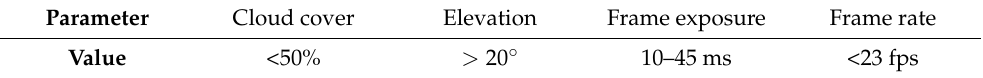
Table 2. Parameters to be considered when planning a pass, with suggested nominal values.